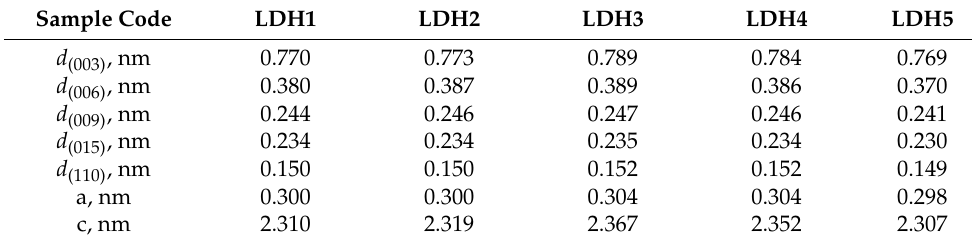
Table 1. Structural parameters of Mg-Al-Fe LDHs.